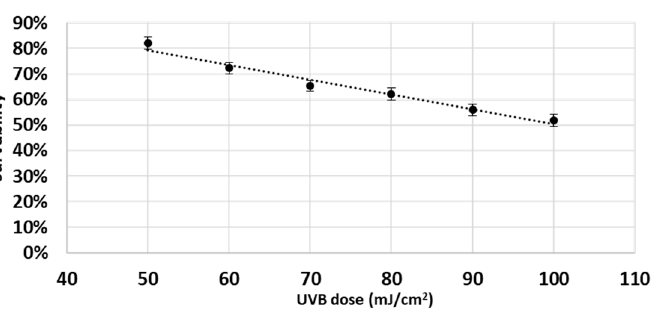
Figure 1. Survival curve of keratinocytes after UVB irradiation. The results show the survival percentage of cells irradiated with UVB compared to non-irradiated cells.